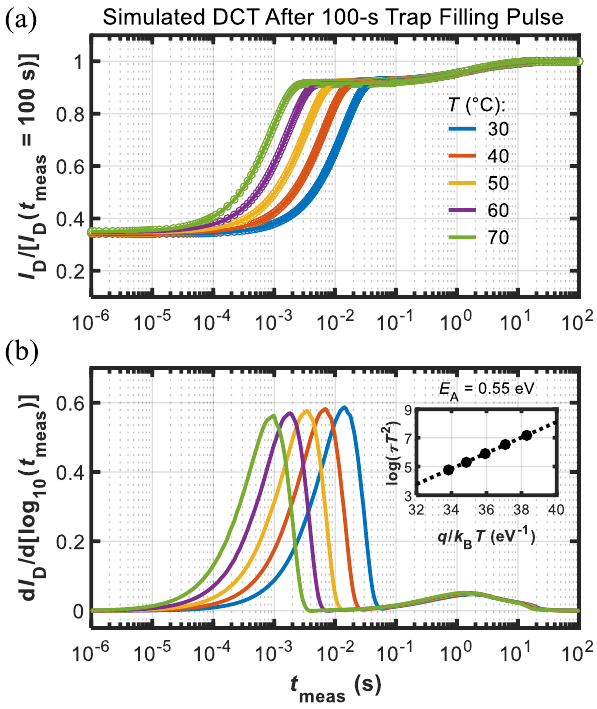
Figure 8. ( a ) Simulated DCTs at different temperatures (see legend) after the long 100 s trap-filling pulse (dots are data and lines are fitting functions). Current was normalized to final value, i.e., I D ( t meas = 100 s). ( b ) d I D /d[log10( t meas )] used for the extraction of the time constants ( τ ) used to build the Arrhenius plot (see inset) that yielded E A = 0.55 eV. Both processes found in Figure 4 were reproduced by the simulations.